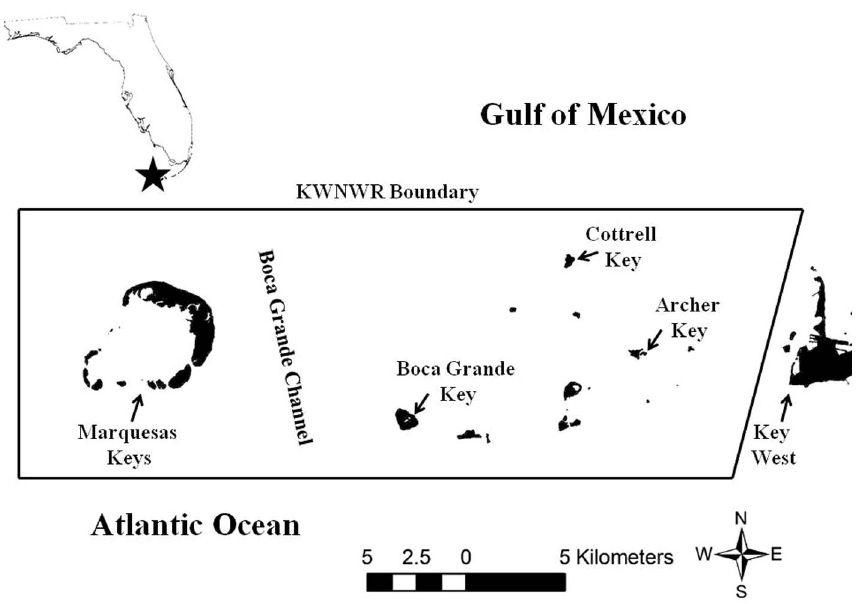
Fig. 1. Location of the Key West National Wildlife Refuge, Monroe County,